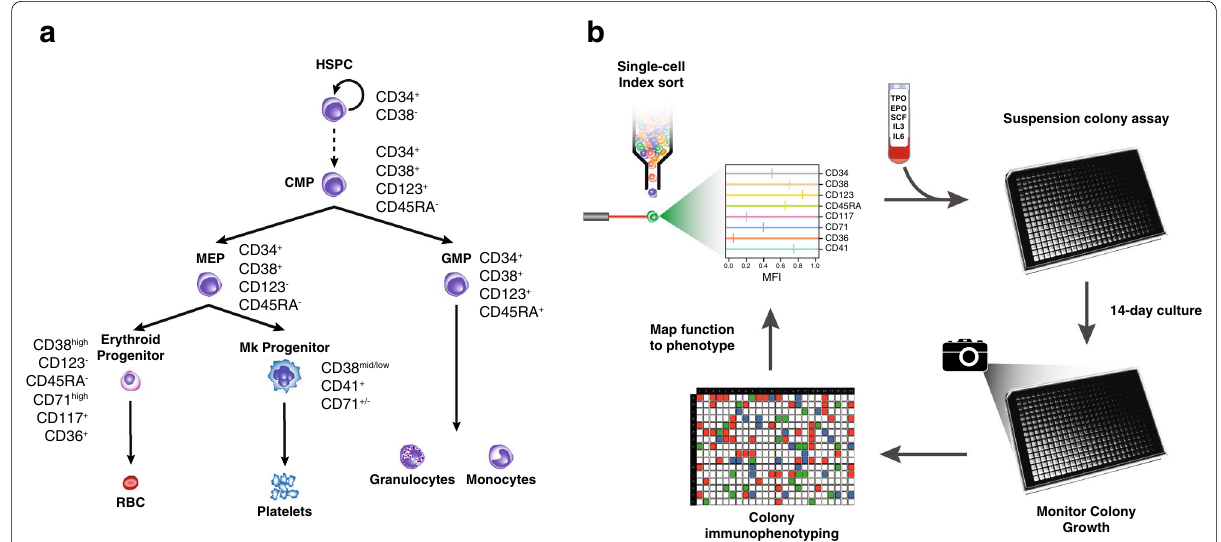
Fig. 1 An unbiased approach for immunophenotypic identification of functionally distinct hematopoietic progenitors. a In the classical view of hematopoietic hierarchy progenitors are defined using complex nested gating strategies on defined immunophenotypic markers [2–4]. b In our approach we labelled a pool of CD34 + HSPCs with the currently established panel of markers and live, single events were index-sorted into an optically-clear 384-well. The progenitor potential of each cell was assessed in a custom colony assay suspension culture system, supplemented with cytokines that can support all myeloid lineages. Colonies were allowed to grow for 14 days and growth was monitored by an automated cell imager. Flow-cytometric analysis identified the type of colony which reflects the lineage potential of the sorted cell. The functional potential of the cell that initiated the colony was then mapped back to the composite phenotype of that